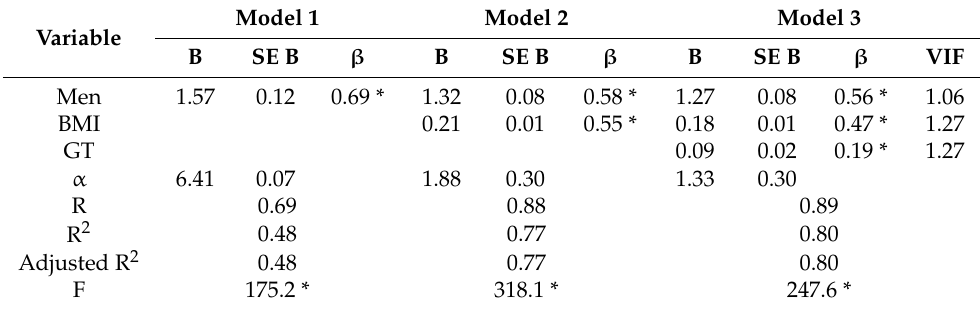
Table 3. Multivariable analysis by stepwise multiple regression analysis.